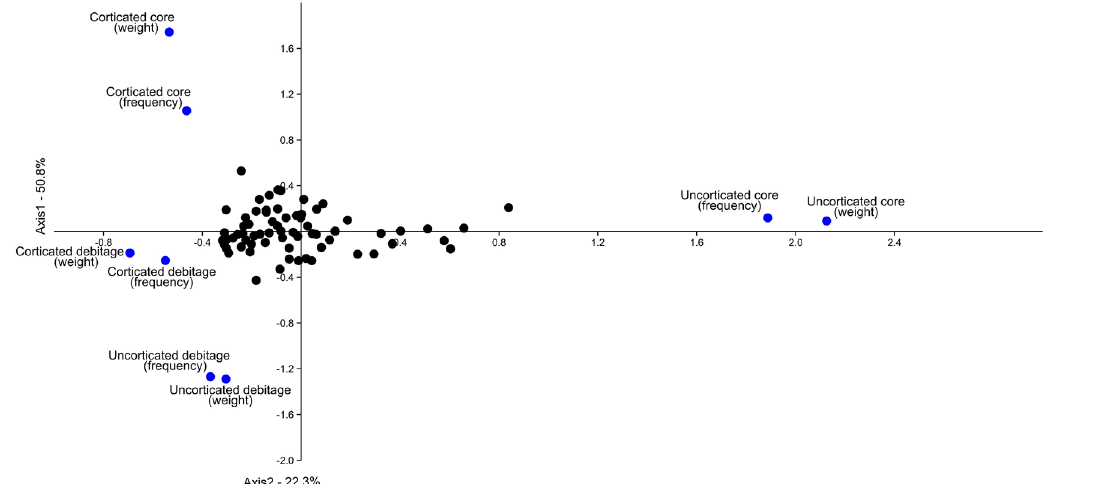
Figure 3: Correspondence analysis of Type 1 limnosilicite and the plot according to the first and second